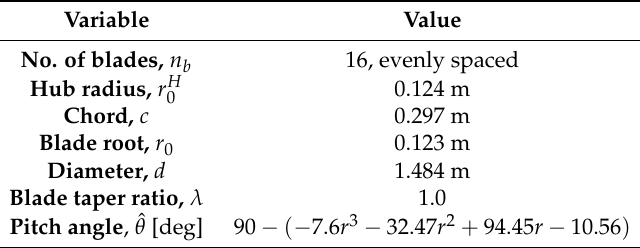
Table 2. Characteristic data of propellers.